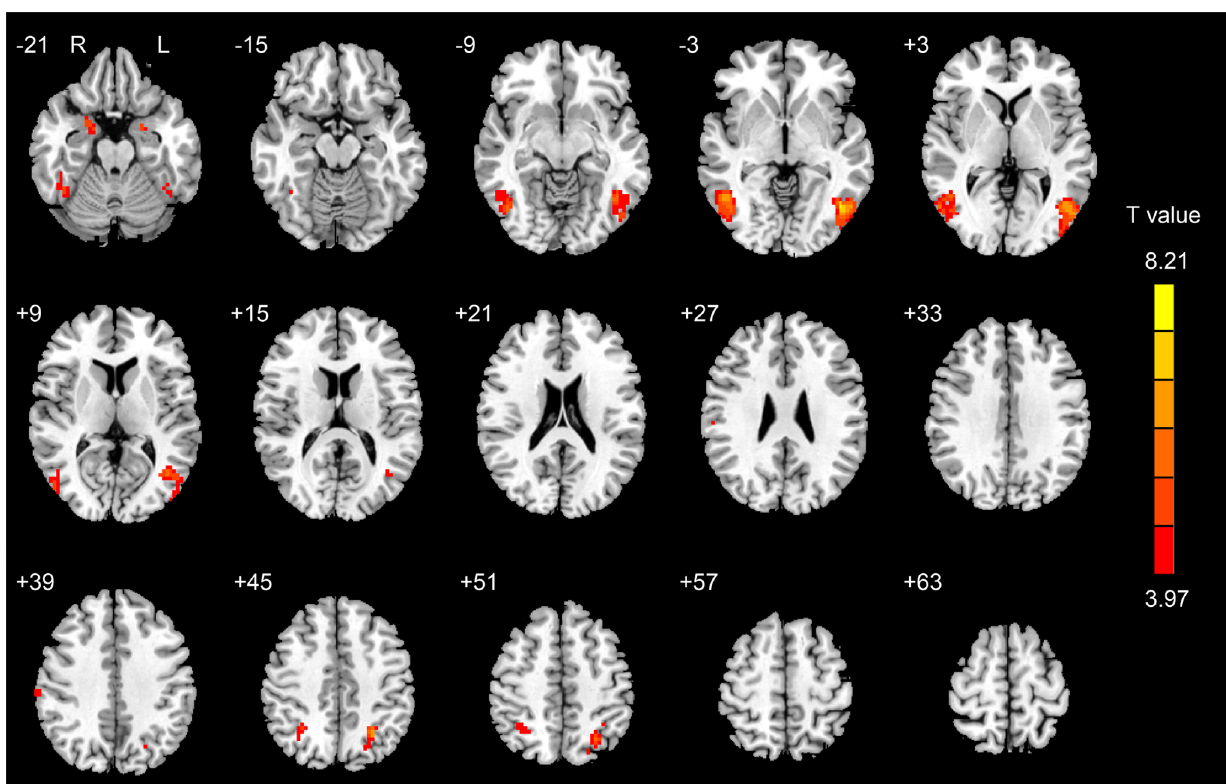
Figure 2. The activated regions relating to the ‘‘Heroin-Neutral’’ contrast for the LA group ( P , 0.05, corrected for Monte Carlo simulations).